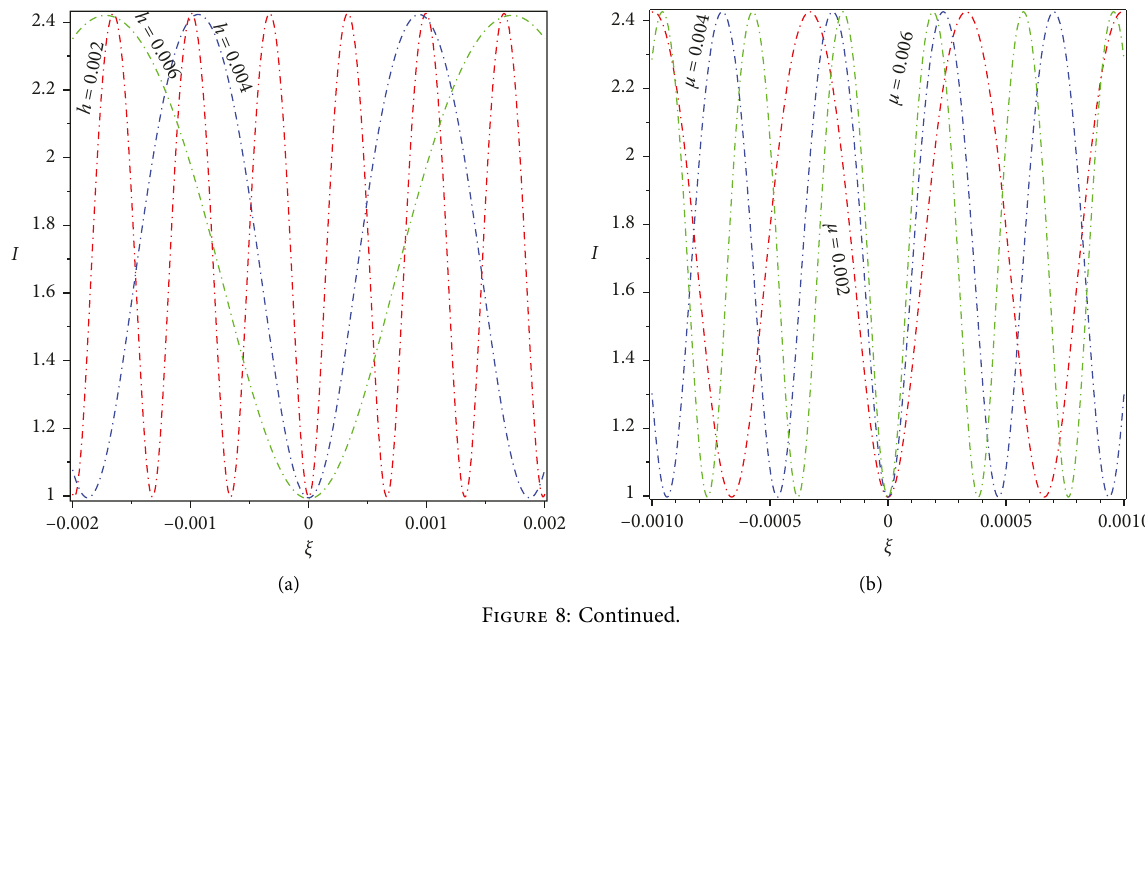
Figure 7: Graphic representation of solution (28) for R 3D graphic and (b) 2D contour